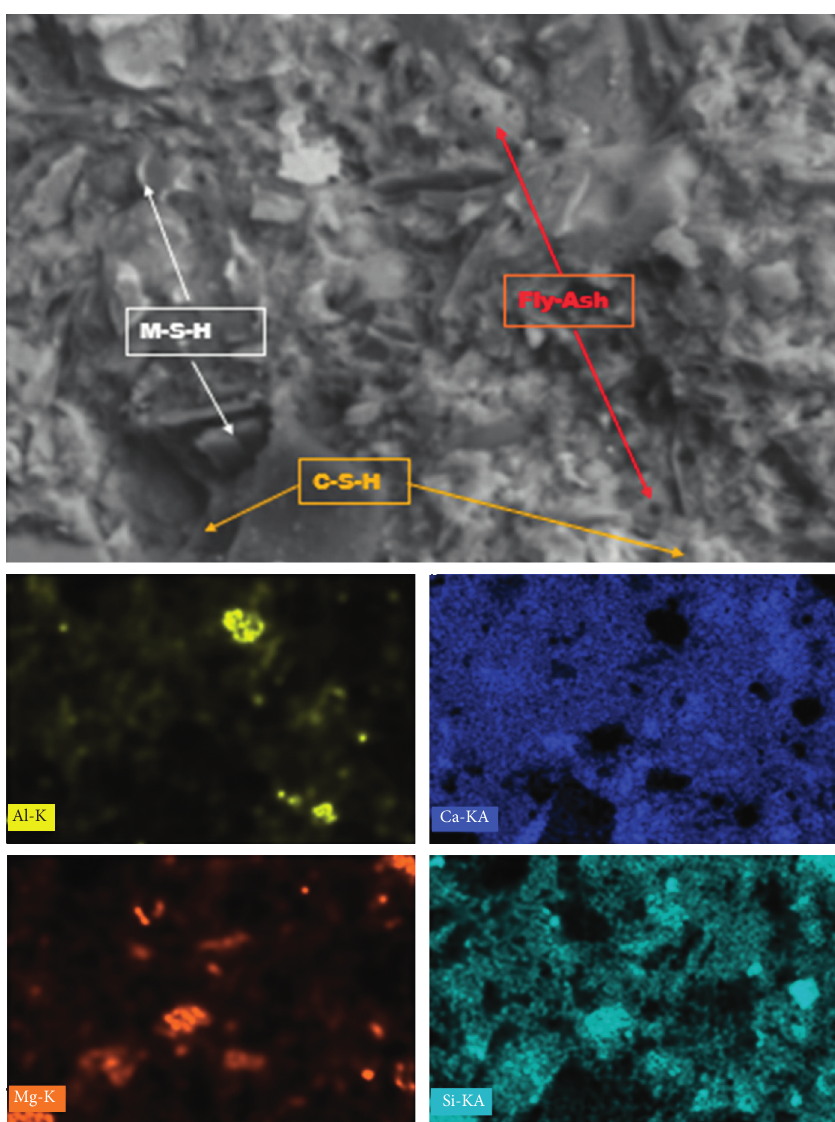
Figure 15: SEM image and corresponding EDX mapping for Al, Ca, Mg, and Si in